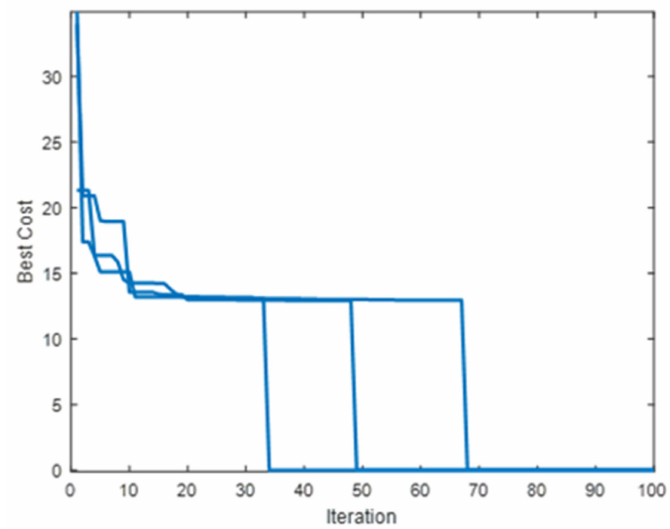
Figure 4. RDS-PSO iteration.